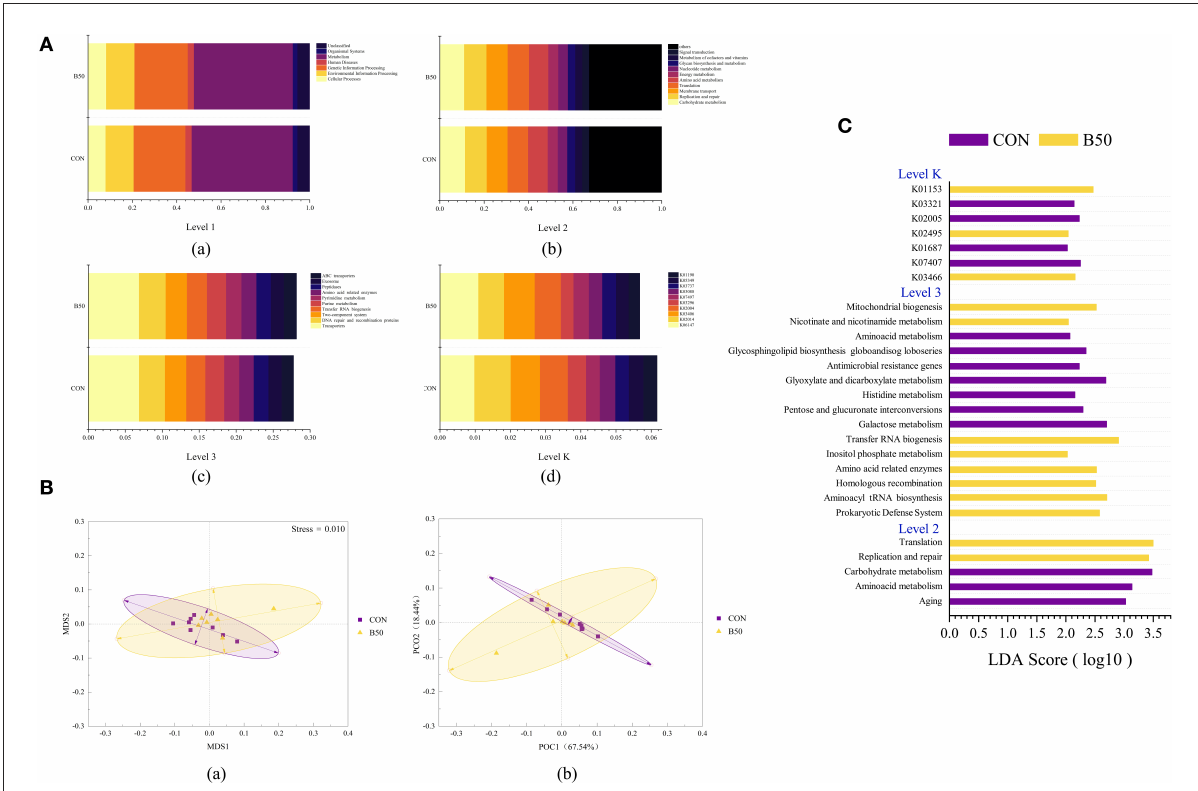
FIGURE8 Functional prediction on the composition and LEfSe analyses for rumen fluid microflora affected by FPPR: (A) Functional prediction on fecal microflora: (a–d) Bar plot of the relative abundance of the predicted function on Levels 1, 2, 3, and K; (B) (a) NMDS plot; (b) PCoA plot; and (C) LAD bar plot for the predicted function of rumen